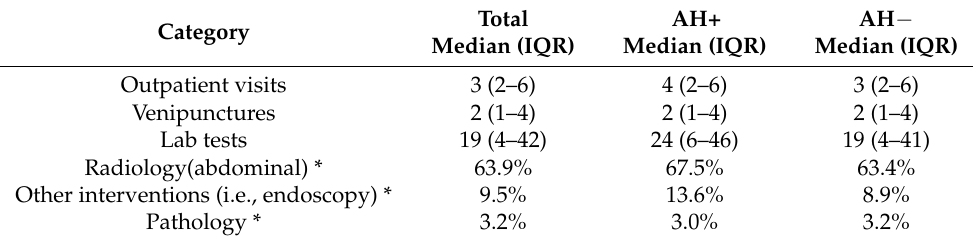
Table 2. Healthcare activities per